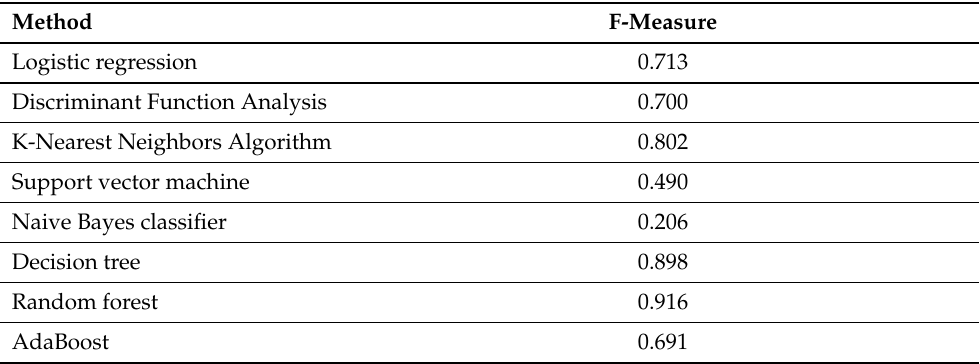
Table 3. F-measure values on a test set under various basic machine learning methods.